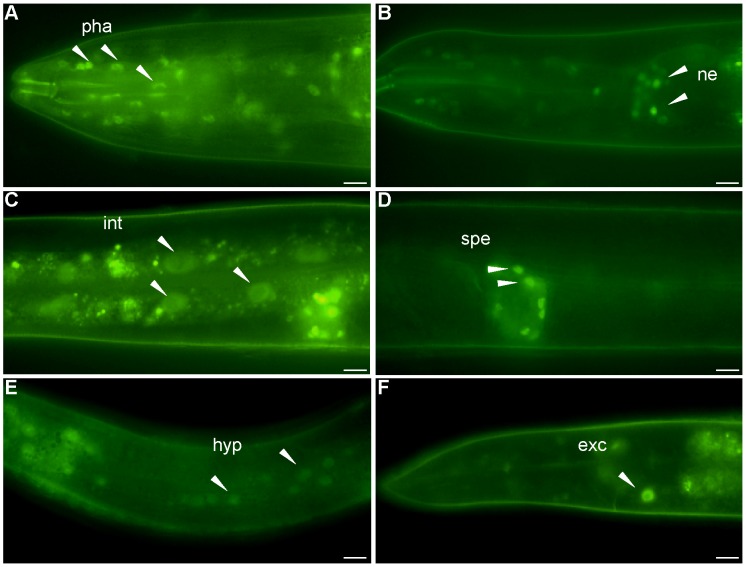
Expression pattern of nhr-62::gfp.
A full length fusion of nhr-62::gfp resides in the nuclei of (A) pharyngeal cells (pha), (B) sensory neurons (ne) (C) intestinal cells (int) (D) spermatheca (spe) (E) hypodermis (hyp) (F) excretory cell (exc). Scale bar is 10 µM.